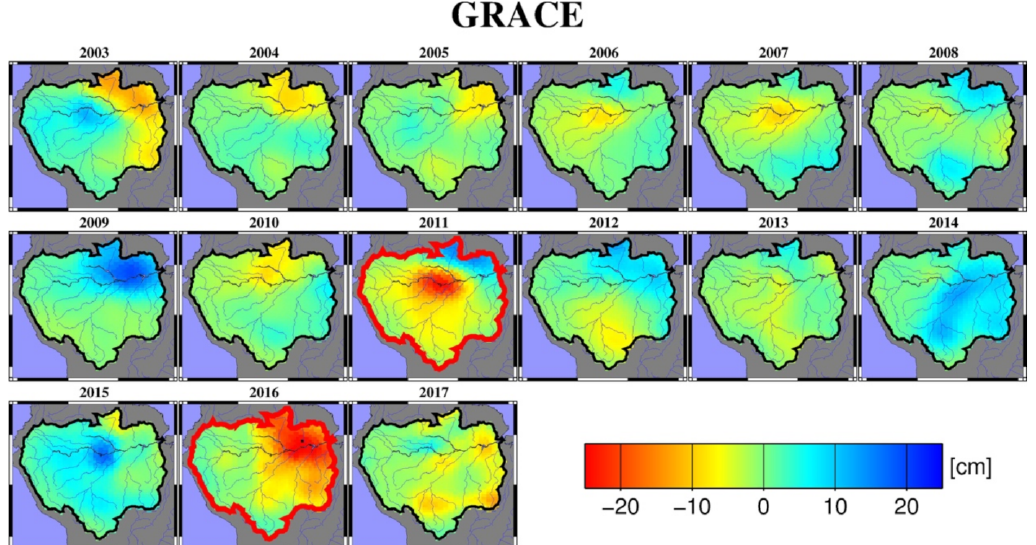
Figure 7. Yearly drought patterns as interpreted from the GRACE TWSC. Note that the yearly drought patterns are the mean nonseasonal TWSC from July of the previous year to June of the current year (e.g., the 1993 drought patterns are the mean during July 1992 through June